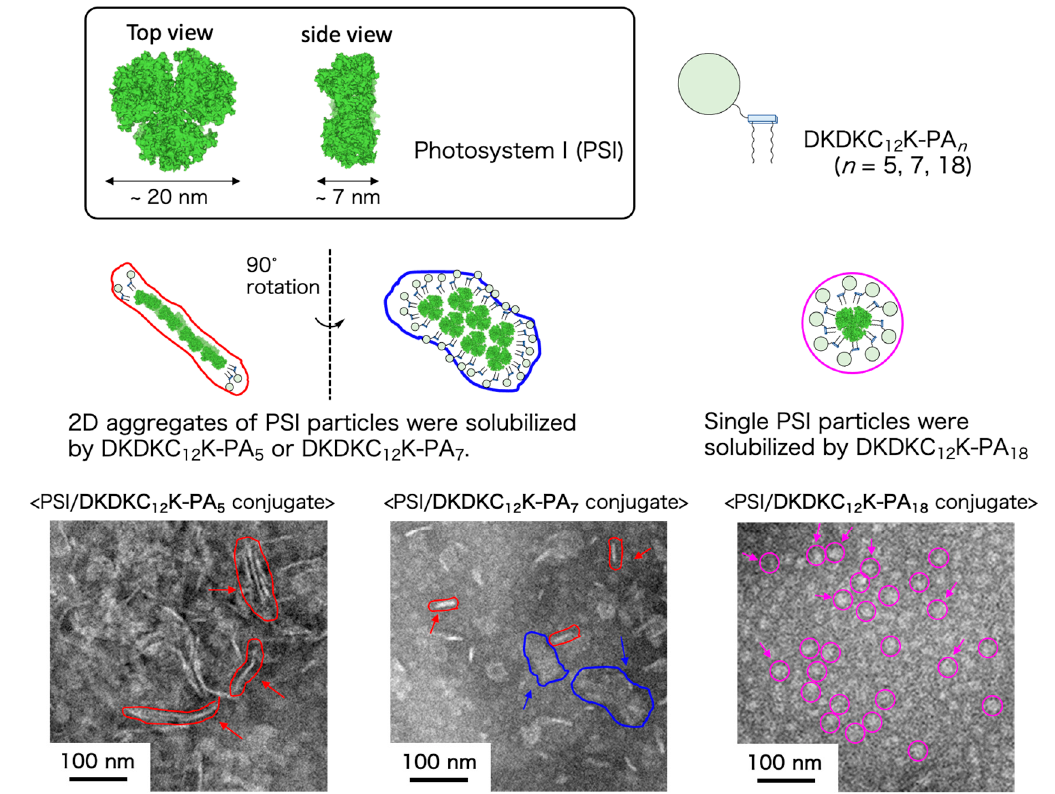
Figure 5. TEM images of the isolated PSI/DKDKC 12 K ‐ PA n conjugates (PSI/DKDKC 12 K ‐ PA 5 conjugates (left low), PSI/DKDKC 12 K ‐ PA 7 conjugates (center low), and PSI/DKDKC 12 K ‐ PA 18 conjugates (right low)) and the schematic illustrations of the expected molecular structures of aggregates, observed in TEM images (upper). 2D aggregates of PSI particles solubilized with DKDKC 12 K ‐ PA 5 or DKDKC 12 K ‐ PA 7 are indicated by red or blue enclosing regions and arrows. While single PSI particles solubilized with DKDKC 12 K ‐ PA 18 are indicated by purple enclosing regions and arrows. Accelerate voltage, 200 kV.